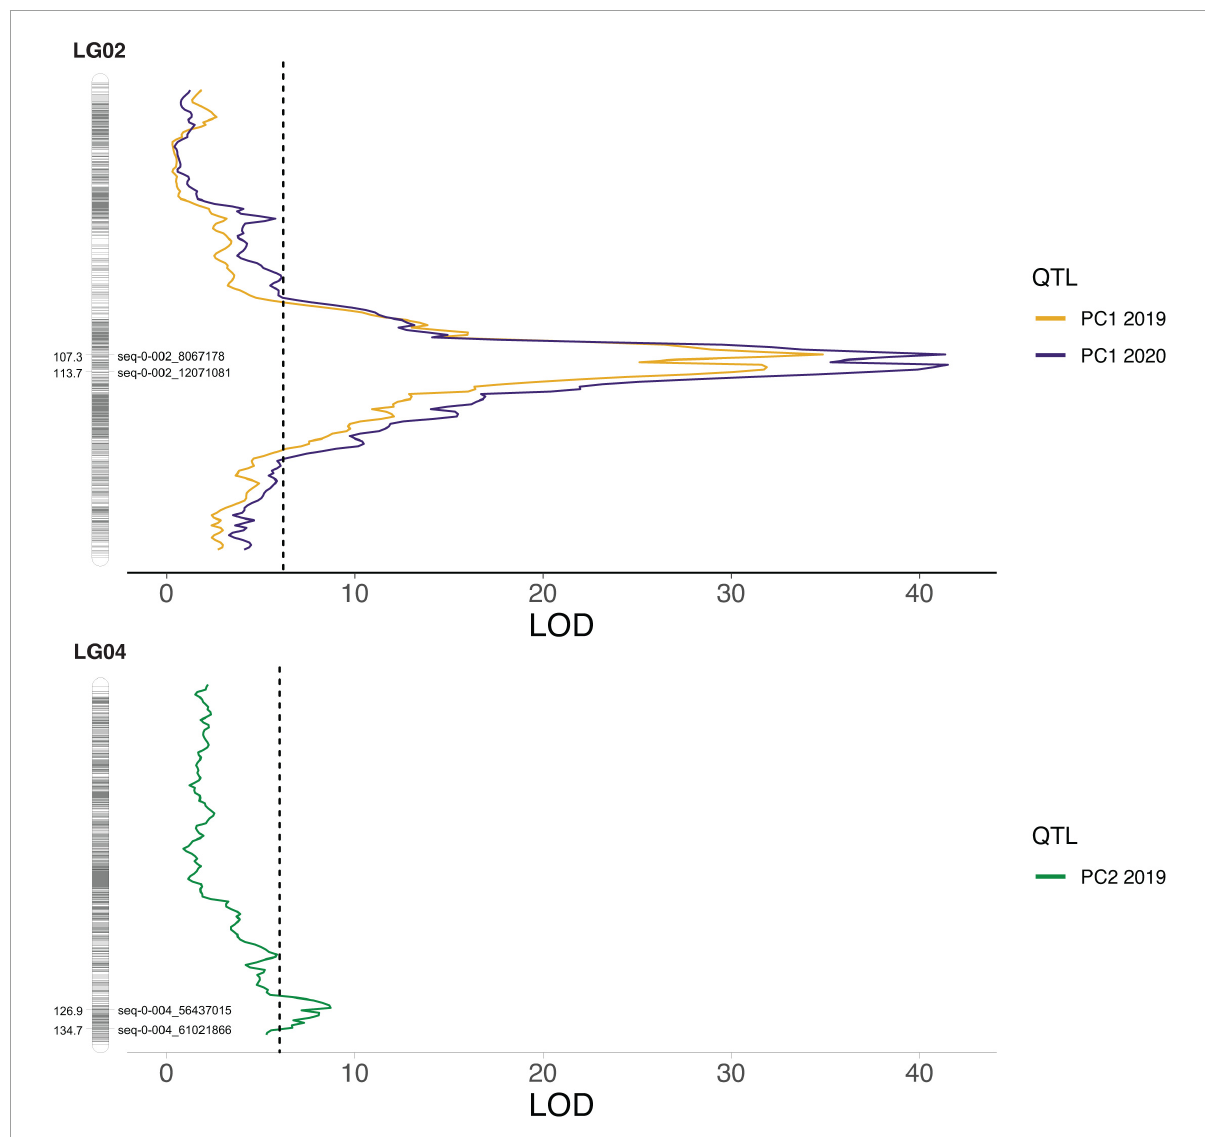
FIGURE4 Quantitative trait locus (QTL) peaks for Principal Component (PC) 1 and PC2 in 2019 and 2020. On both linkage groups (LGs) the markers delimiting the –2 LOD confidence interval are